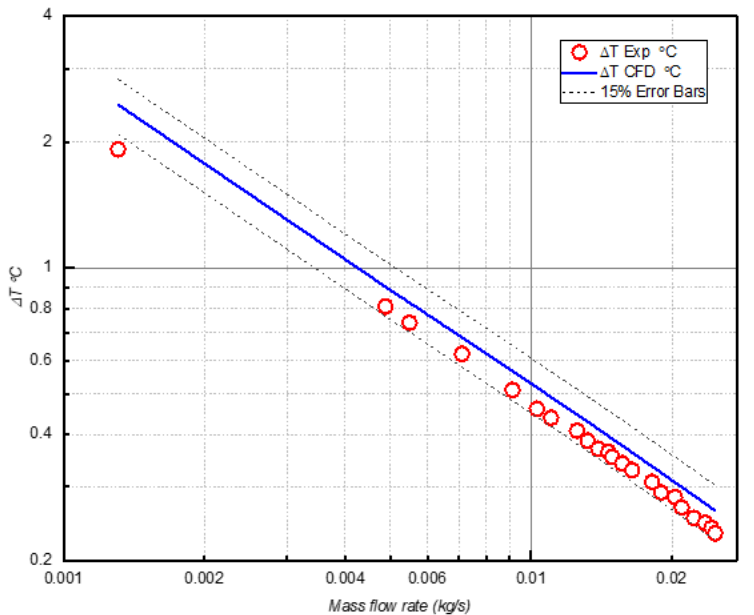
Figure 11. The temperature difference between the outlet and inlet of the HTF at different mass flow rates.